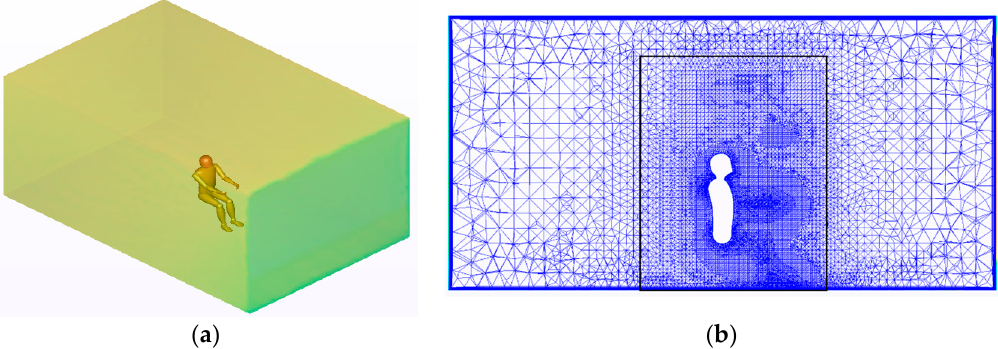
Figure 6. ( a ) CFD model layout and ( b ) fluid sub-domains and mesh elements.